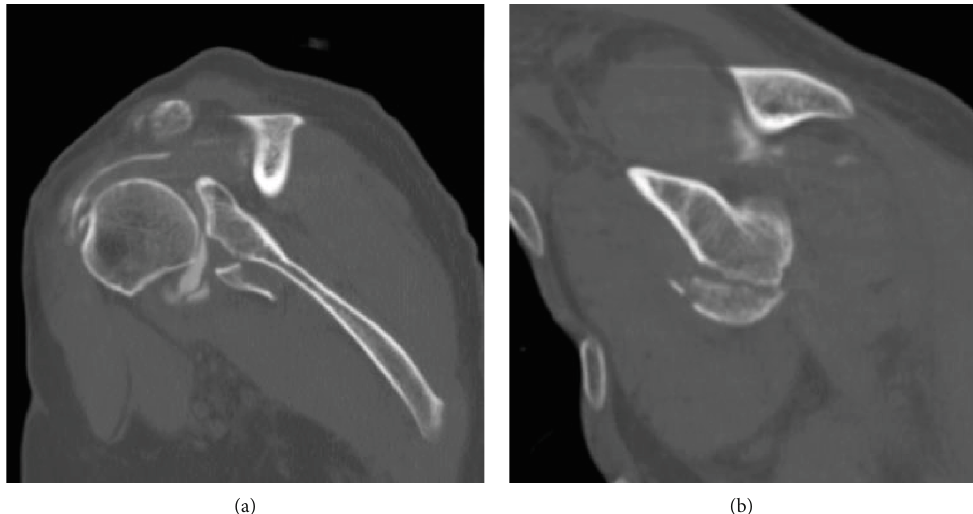
Figure 5: Coronal (a) and sagittal (b) CT images demonstrating comminuted bony Bankart fracture involving approximately 35% of the glenoid